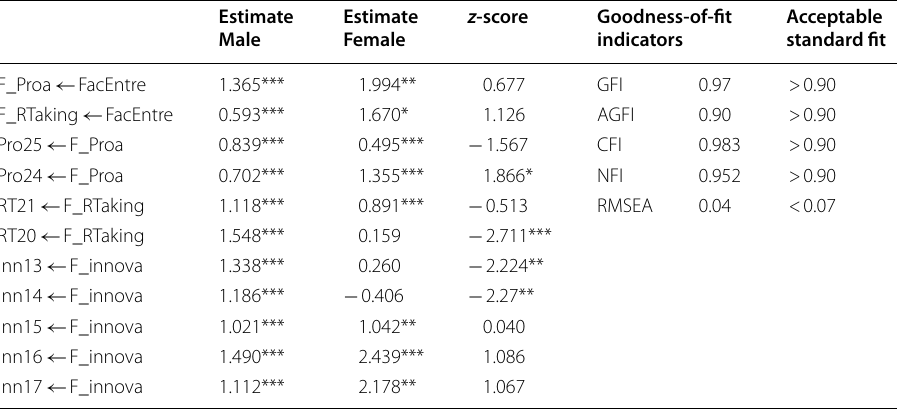
Table 4 SEM results for FEO construct subject to